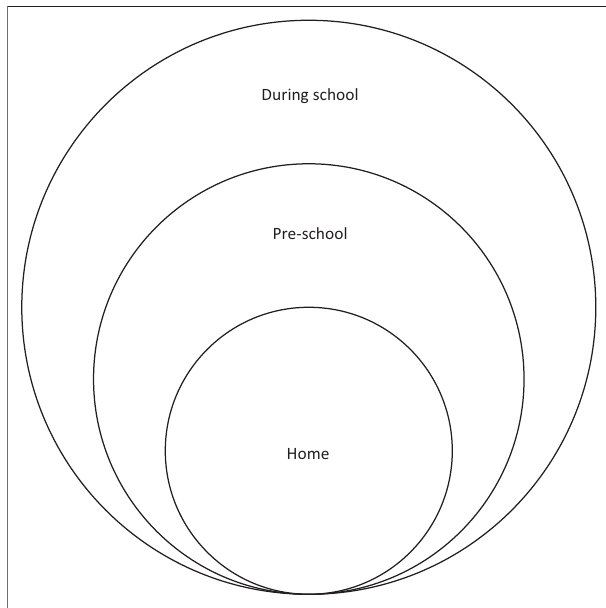
FIG URE 1 : Graphical representation of contexts of linguistic exclusion experienced by D/deaf learners.